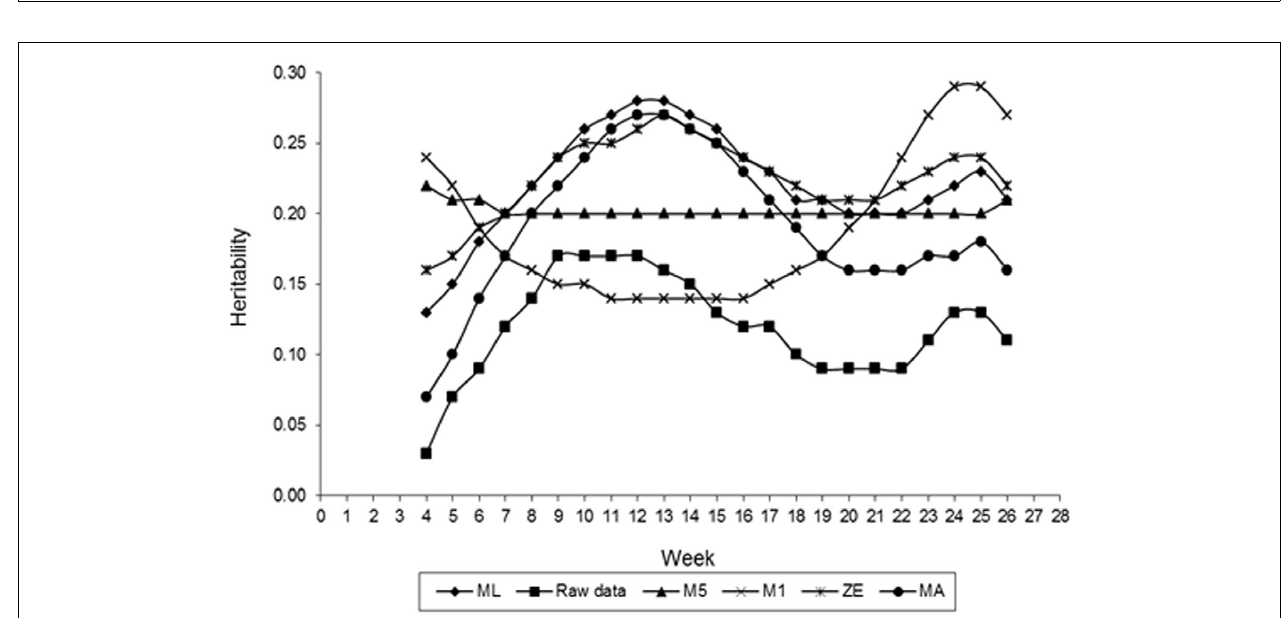
FIGURE 5 | Estimates of heritability of fecal egg count (FEC) over time for different values of λ .